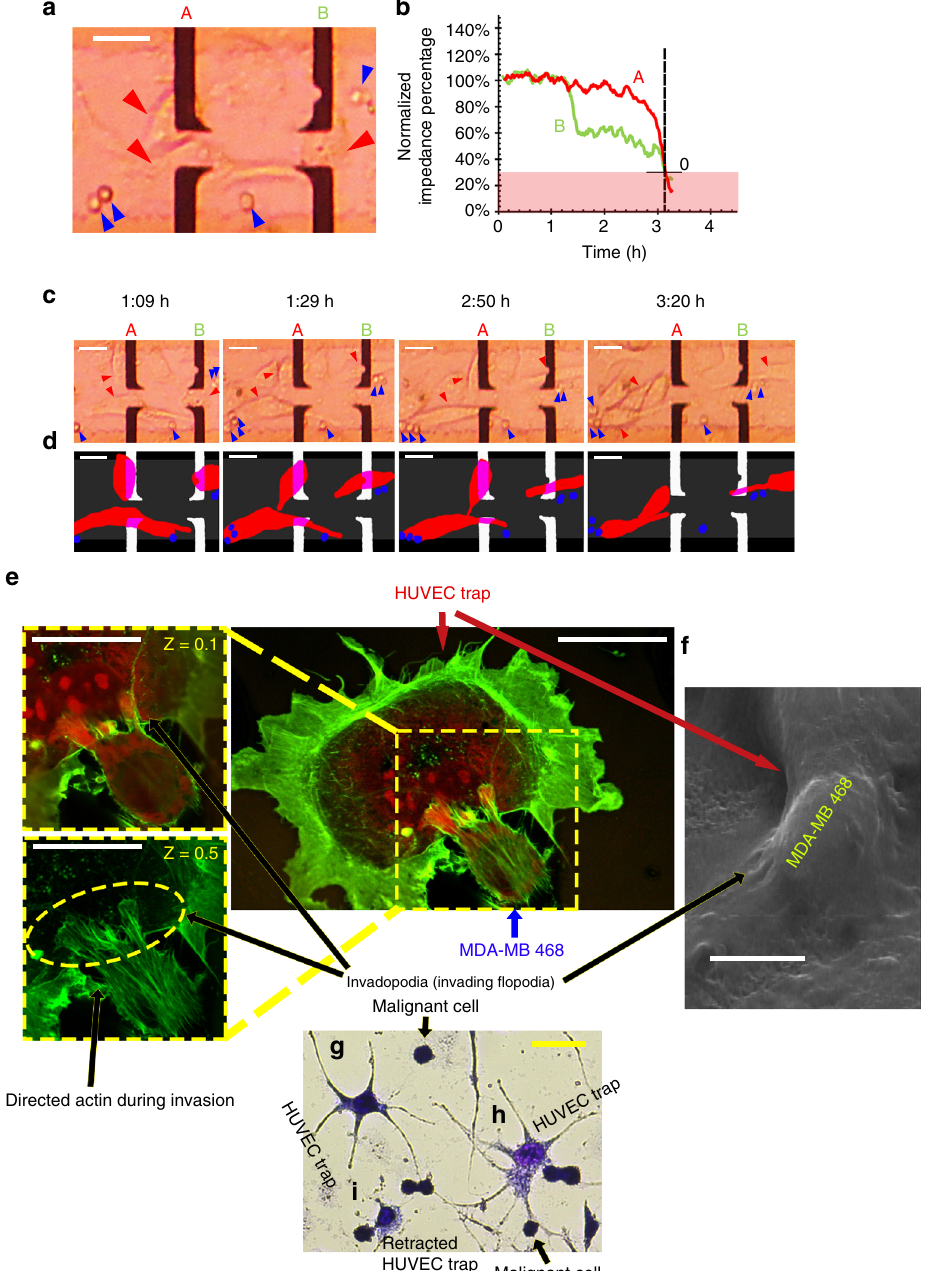
Fig. 2 Interaction between sensing traps and malignant cell lines. a Optical image from two MDA-MB 468 (human breast metastatic carcinoma) clusters captured by the sensing traps of Metas-Chip. b Characterization of the Metas-Chip using MDA-MB 468 cell line spiked in whole solution. c Time-lapse optical images, which shows high correlation with schematic ( d ) explaining the dynamic balance responsible for the capture of metastatic cells and sharp reduction in the response occurs when the single vascular cell being detached from the sensing electrode by metastatic cells. Forces acting on the HUVEC traps just have been initiated from metastatic attraction of cancer cells as, no drag forces, no fl uid fl ow and no reaction forces applied from the system. Individual cells are < 10 μ m wide, and the sensing electrodes covered by single HUVECs are > 15 μ m wide. Whole metastatic interaction detected by the system has been occurred in less than 3.5 h. e Confocal images from invasion of MDAMB468 cell into single-HUVEC trap. Directional assembly of the actin micro fi laments and formation of invadopodia entered into the membrane of vascular cell are the results of receiving chemokines S100A8 and S100A9 chemical signals from the HUVEC by chemo-sensing part of the metastatic cells located in the external of fi lopodia and reinforced by MMP2 family. Various images taken from the cells in two different heights ( Z = 0.1 and Z = 0.5) better presented the entrance of metastatic cell ’ s invadopodia into the HUVEC trap. f FE-SEM image of a vascular cell invaded by a metastatic breast cell also presented the direct interaction of caner cells' invadopodias with the HUVEC ’ s membrane. Geimsa stain image from the interaction between MDA-MB468 cells and HUVECs presented: g a non- invaded trap; h start of invasion; i invasion and start of retracting perturbation induced into HUVECs depend on the start time of each interaction. The scale bars are 25 µ m in